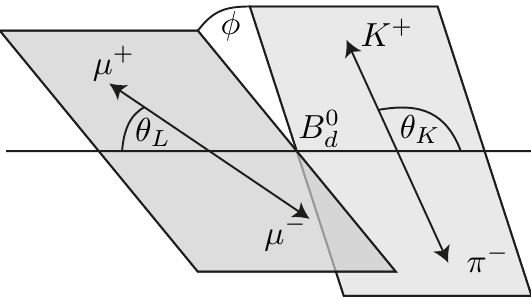
+ (cid:22) ! K decay showing the angles (cid:18) (cid:3) (cid:22) (cid:0) d